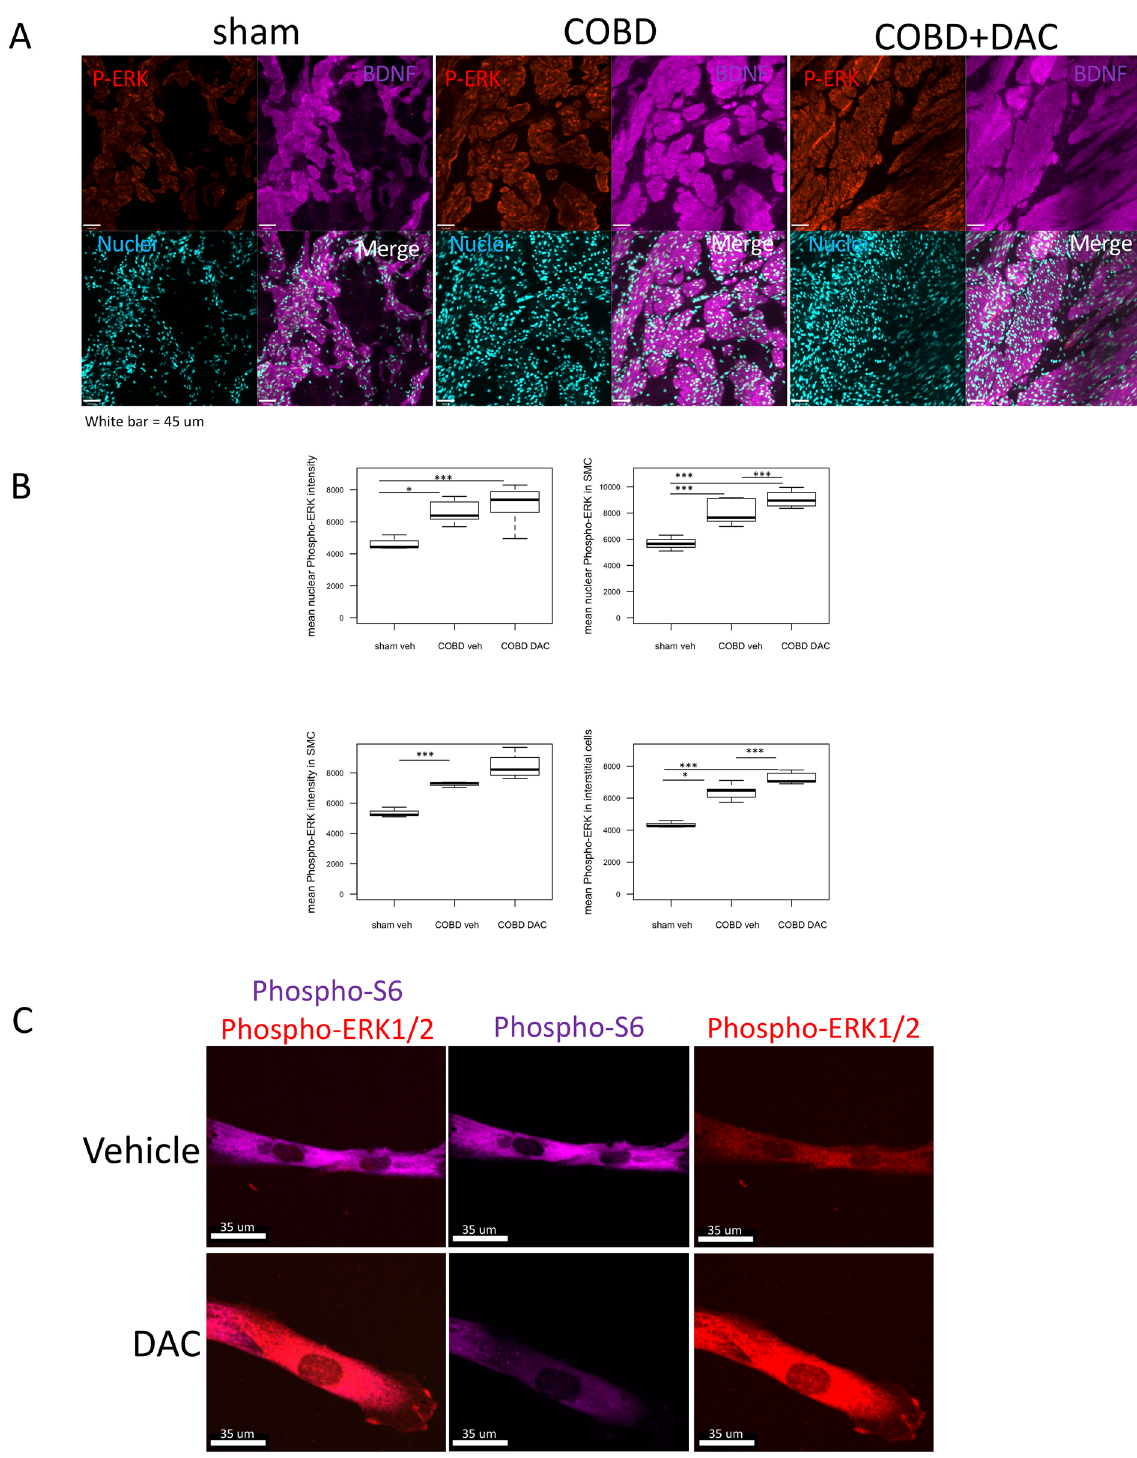
Figure 5. Activation of ERK1/2 is associated with persistent and decitabine (DAC)-resistant features of COBD. ( A ) Localization of activated ERK was performed by quantifying phospho-ERK1/2 (red-Cy3) in the SMC bundles (positive for BDNF, purple-far-red, as in previous work) 26 , and compared to the nuclear staining by DAPI (light blue), on Volocity. ( B ) Staining for Phospho-ERK was most intense in the nucleus of COBD cells. Nuclear phospho-ERK staining of interstitial cells and SMC was increased by DAC treatment. ( C ) Primary human bladder SMC maintained in 2% growth media were treated with vehicle or 2 μM DAC for 48 h to examine if signaling was altered by DAC treatment. Phospho-S6 (purple-Far-red) and phospho-ERK (red-Cy3) were detected by immunofluorescence, which showed a reduction of Phospho-S6 and an increase in phospho- ERK1/2. *p < 0.05, **p < 0.01, ***p <